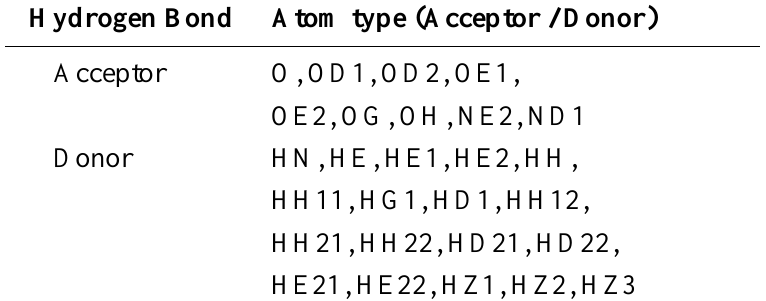
Table 1. The atom types of the hydrogen bonds (CHARMM force field).